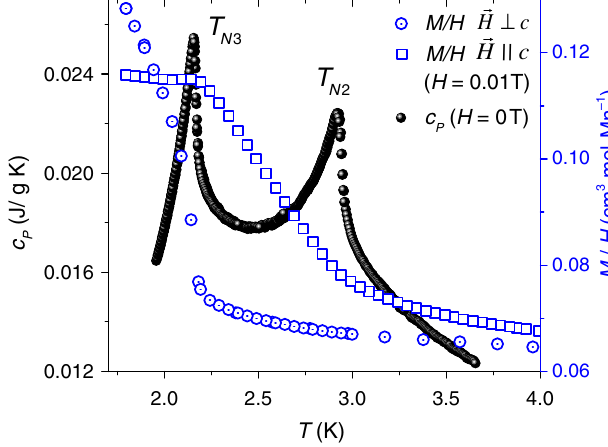
FIG. 4. Low-temperature region of the zero-field specific heat and low-field static magnetic susceptibility ( M=H ) measured with μ 0 H ¼ 0 . 01 T for two different field orientations ⃗ H ⊥ c revealing the two successive magnetic transitions at about 3 and 2.2